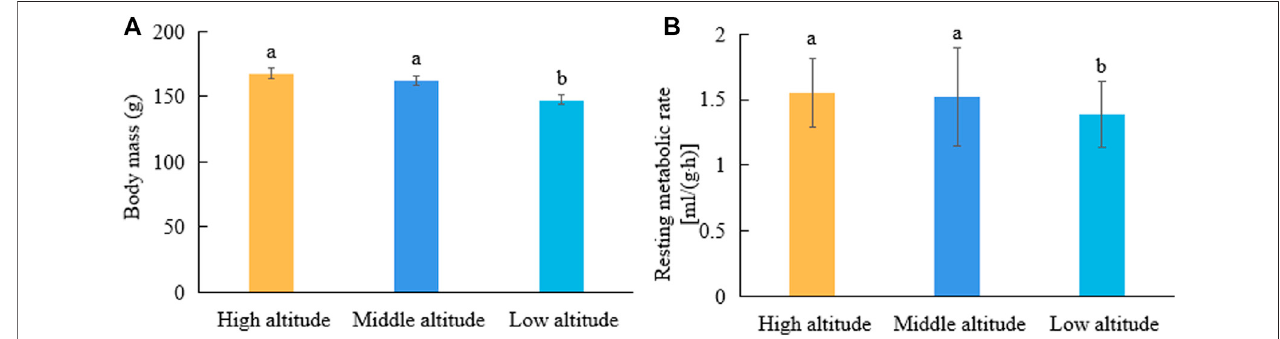
FIGURE 1 | Comparisons of body mass and RMR of plateau pikas from regions with different altitudes. Different lowercase letters indicate signi fi cant differences among elevations ( p < 0.05). Same lowercase letters indicate have not signi fi cant difference among elevations (ns p >